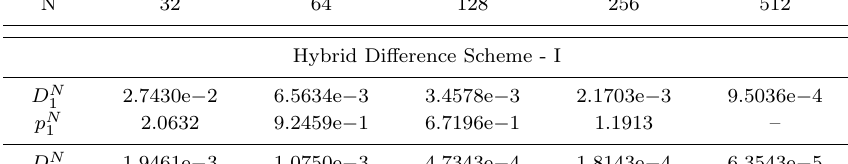
Table 5. Values of D N N